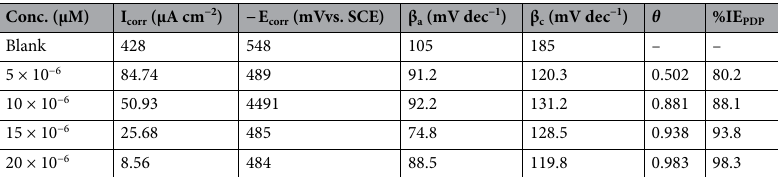
Table 1. PDP kinetic parameters for ( DTG